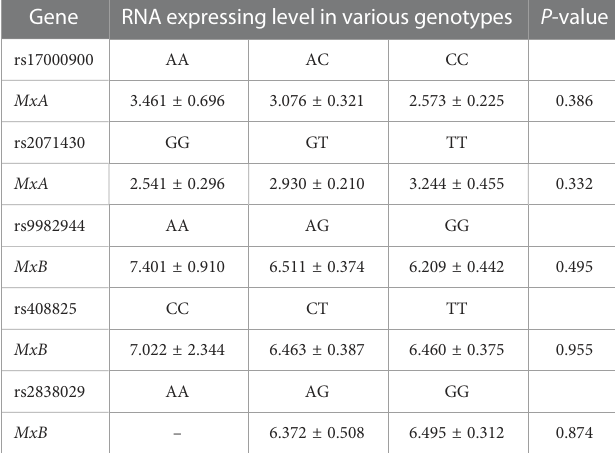
TABLE 4 RNA expressing level of the MxA and MxB gene in HCV patients with various genotypes of these two genes. Gene RNA expressing level in various genotypes P